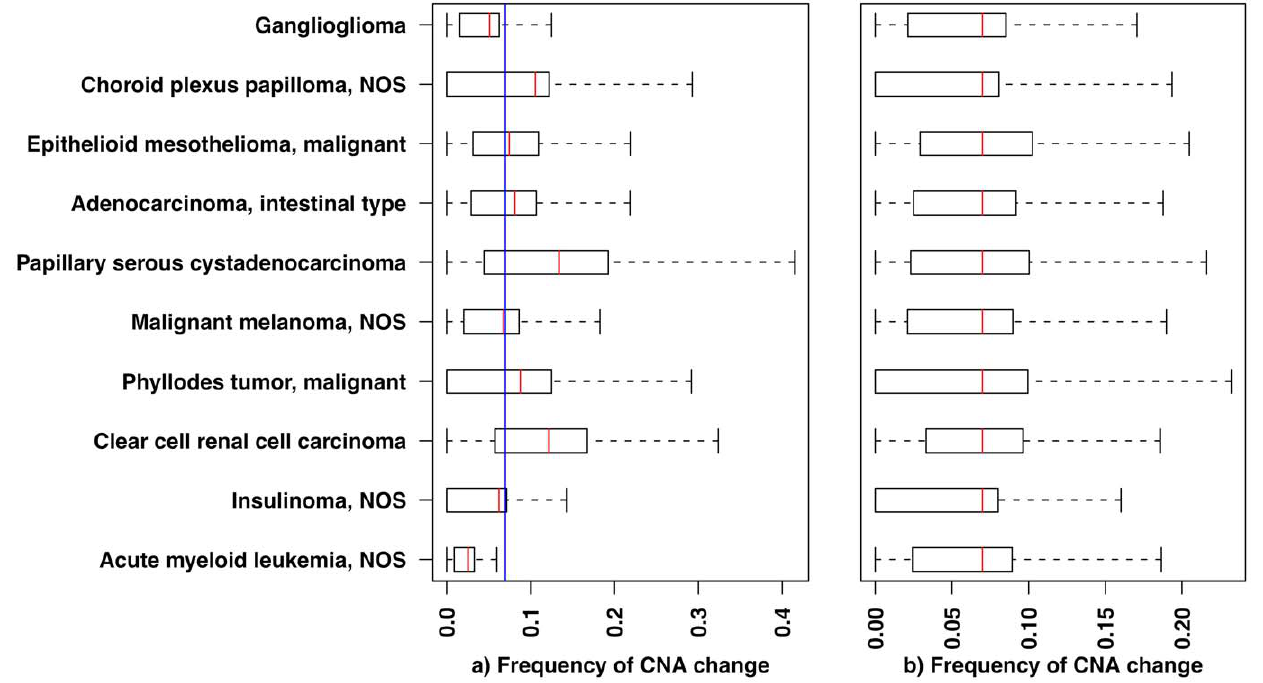
Figure 1. The overall frequency of genomic copy number alterations (CNA) differs among cancer types. Boxplots show the CNA frequency distributions among tumor samples in 10 randomly selected cancer types. The boxplot delineations mark the percentiles 5%, 25%, 75% and 95%. The red lines indicate the mean frequency for each cancer type, whereas the blue line represents the overall mean frequency across all 160 cancer types analyzed here. Frequency values are defined as the ratio of number of samples showing a CNA for a genomic region (i.e., cytogenetic bands) over total number of samples in that cancer type. a) Before normalization b) After normalization. In b) the nominal frequency distribution for each cancer type is re-scaled so that its mean matches the overall mean across all cancer types. (NOS – ‘‘not otherwise specified’’: high-order classifications, not further assigned to more detailed levels).